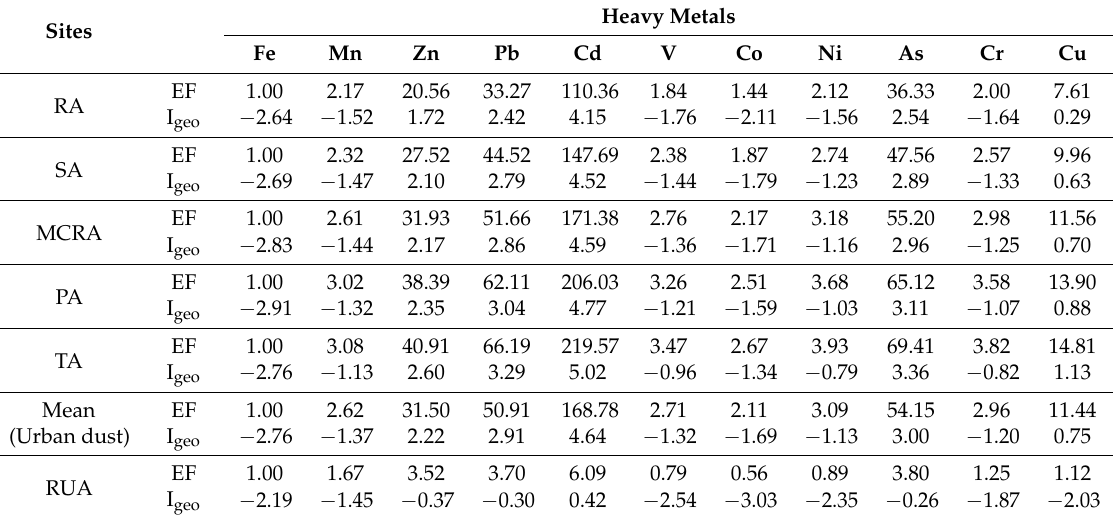
Table 5. The enrichment factor (EF) and I geo of heavy metals in road dusts of different functional areas.